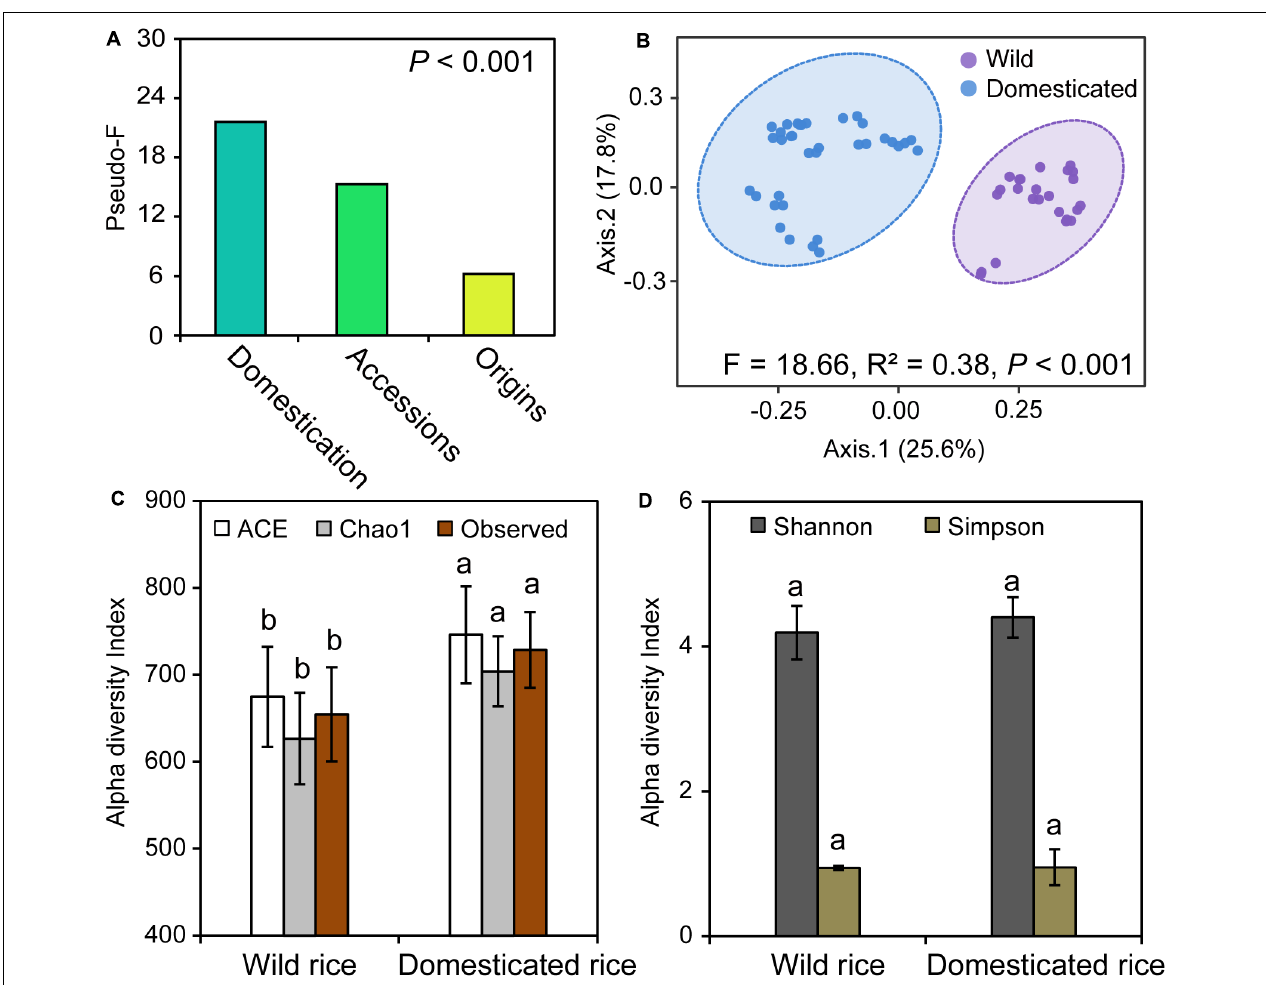
FIGURE 1 | (A) The permutational multivariate analysis of variance (PERMANOVA) output showing the importance of rice domestication, rice species, and origins factors shaping the rhizosphere fungal community. (B) Compositional changes of fungal communities in the rhizospheres of wild and domesticated rice. (C,D) Alpha diversity indices of fungi in the rhizospheres of wild and domesticated rice. The pseudo-F value was used as a proxy for the importance of the factor (A) . For the PERMANOVA of domestication factor, all samples were separated into two groups: wild and domesticated rice. For the PERMANOVA of accessions factor, all samples were separated into 12 groups: 12 rice species as described in section “Materials and Methods”. For the PERMANOVA of origins factor, all samples were separated into two groups: African rice and Asian rice. Principal coordinates analysis (PCoA) was performed based on the Bray–Curtis dissimilarity matrix at operational taxonomic units (OTUs) level across all the samples (B) . Ellipses demonstrate the mean ± 1 SD, wild rice in purple and domesticated rice in blue. In panels (C,D) , wild rice rhizosphere samples, n = 24; domesticated rice rhizosphere samples, n = 35. Different letters within each column indicated significant differences between wild and domesticated rice based on a one-way ANOVA with a Tukey test at the P < 0.05 level.